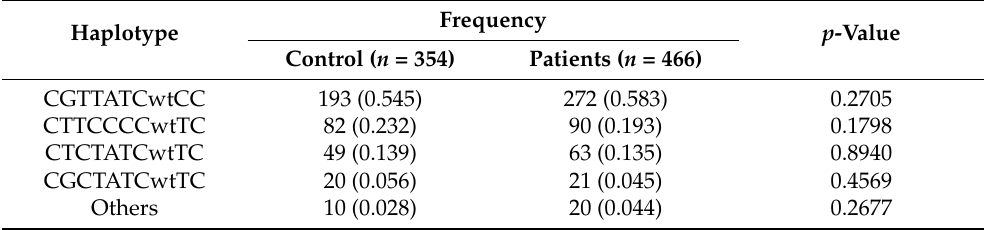
Table 3. Haplotype frequencies of IFITM3 polymorphisms in the healthy controls and Alzheimer’s disease (AD)